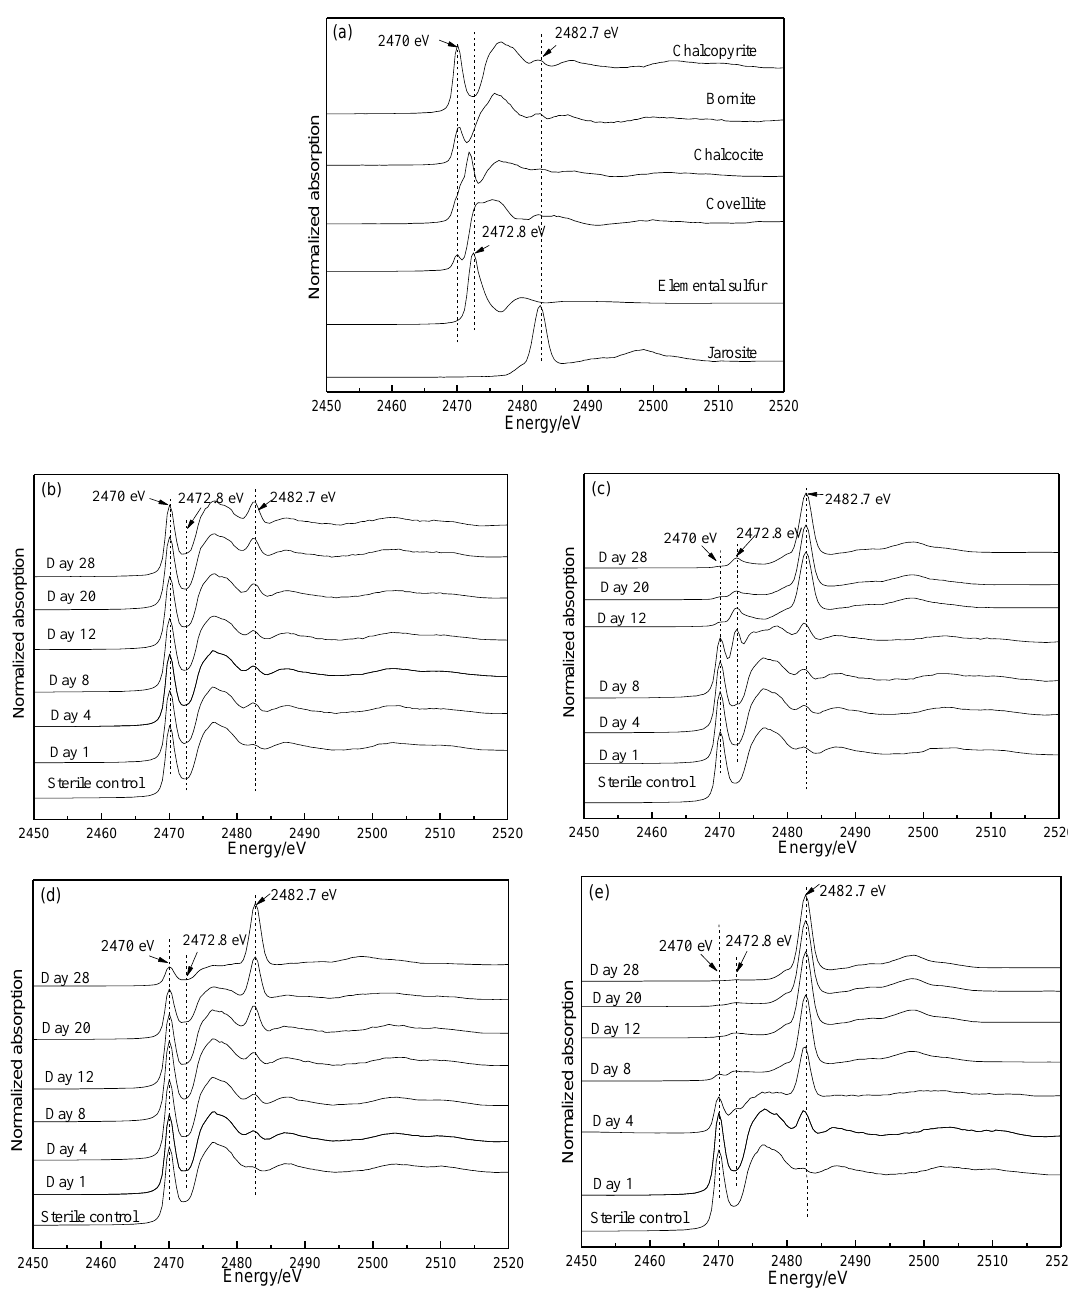
Figure 7. Normalized S K - edge XANES spectra of reference sulfur-containing compounds ( a ), chalcopyrite bioleached by mesophilic culture from day 1 to day 28 and in the sterile control at 30 °C on day 28 without Ag + ( b ) and with 0.3% of Ag + ( c ) and the spectra of chalcopyrite bioleached by thermophilic culture from day 1 to day 28 and in the sterile control at 48 °C on day 28 without Ag + ( d ) and with 0.3% of Ag + ( e ).